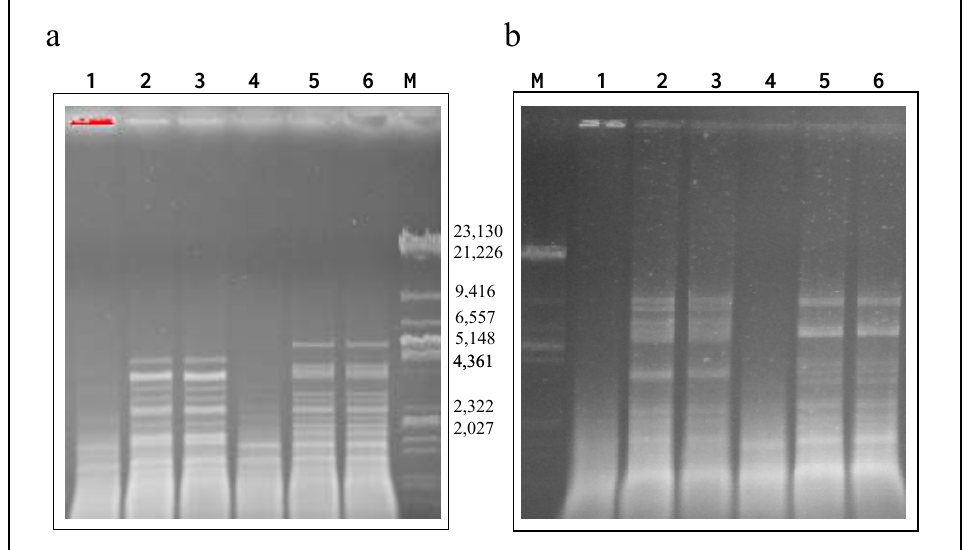
Figure 4. Gel electrophoresis of Hin fI (a) and Rsa I (b) digestion of DNA extracted from respiratory deficient mutants and parental strains. The molecular weight markers of the λ Eco RI and λ Eco RI- Hind III mix are shown in Lane M. The fragment sizes are listed in base pair units beside the lanes. The other lanes contained the DNA restriction digestion fragments from the following